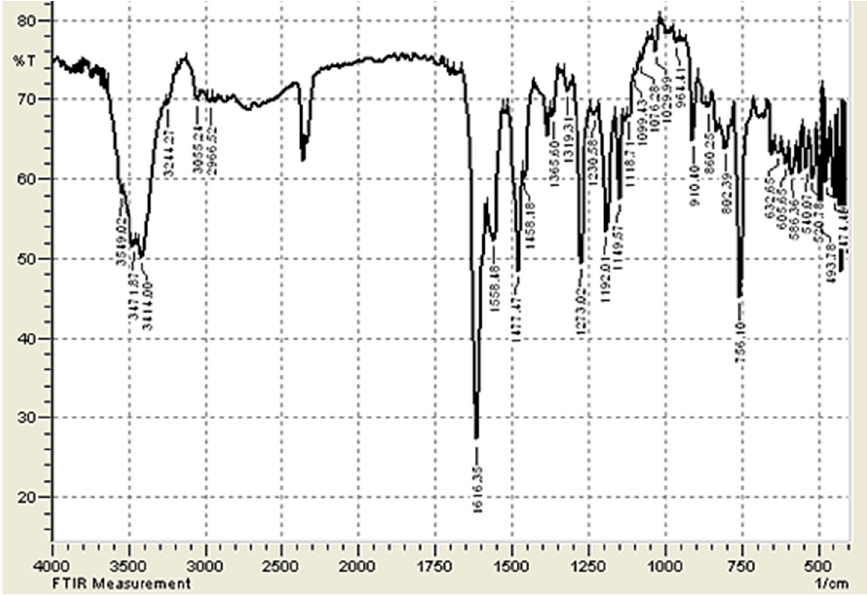
Figure 1. FT-IR spectrum of Schiff base 1 . Table 3. 1 H-NMR spectral data for Schiff bases 1 – 3 .